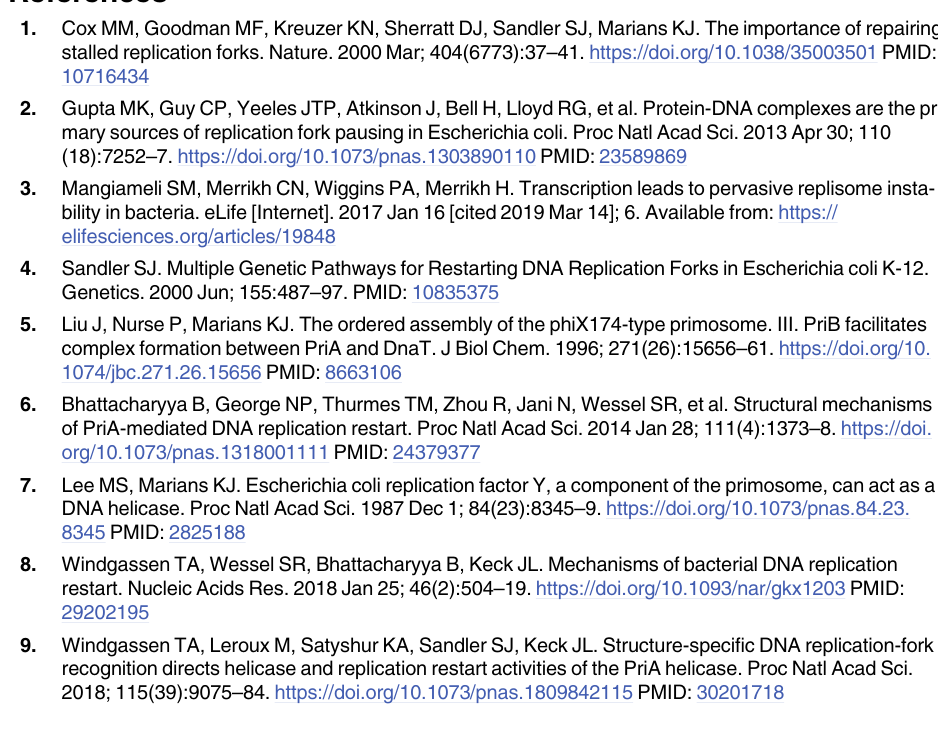
S1 Table. Oligonucleotides used to prepare synthetic